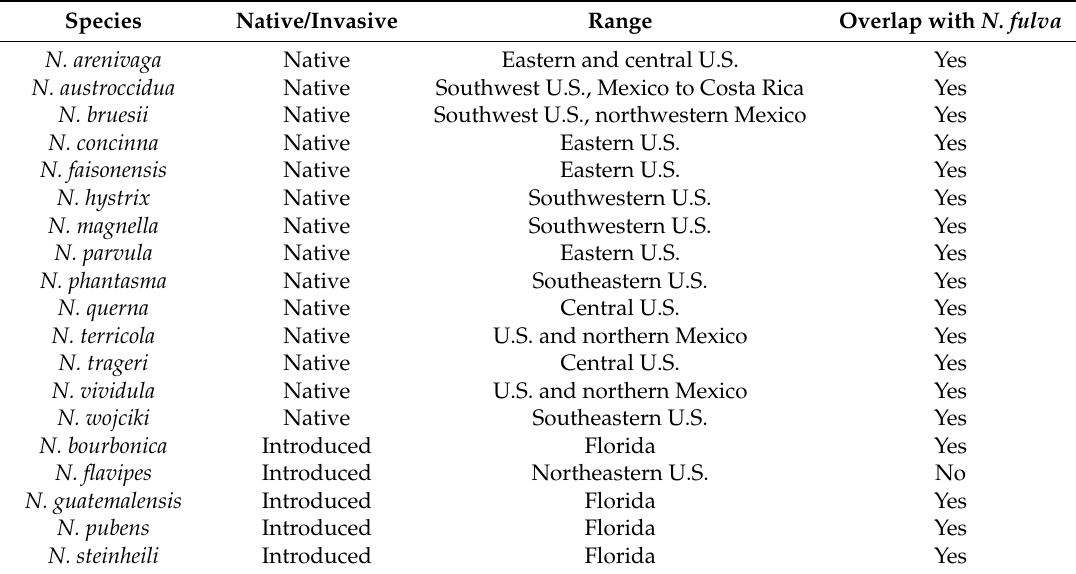
Table 1. Distribution of species in the genus Nylanderia and their classification as native or invasive in the United States